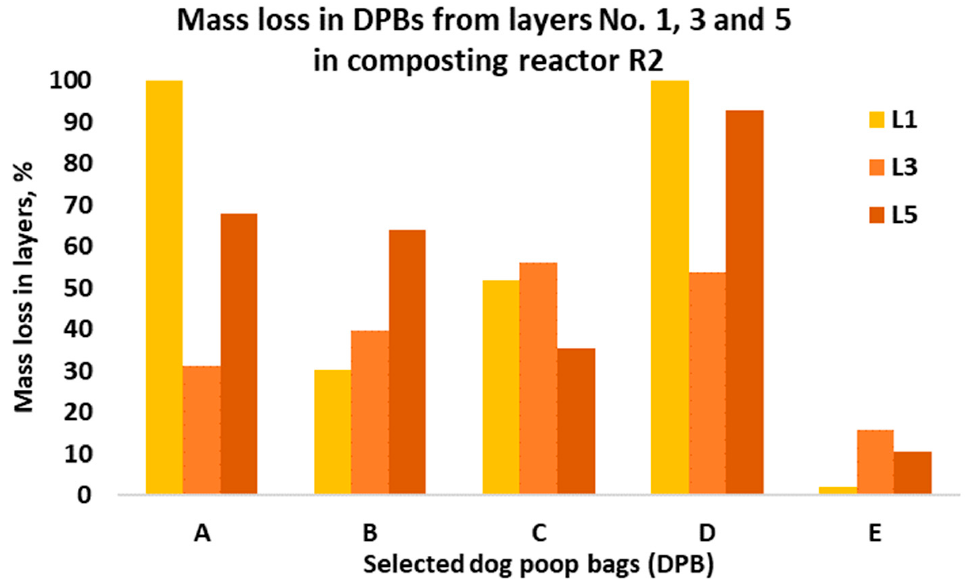
Figure 6. Mass loss of the investigated dog poop bags sampled from the layers in the composting reactor R2.